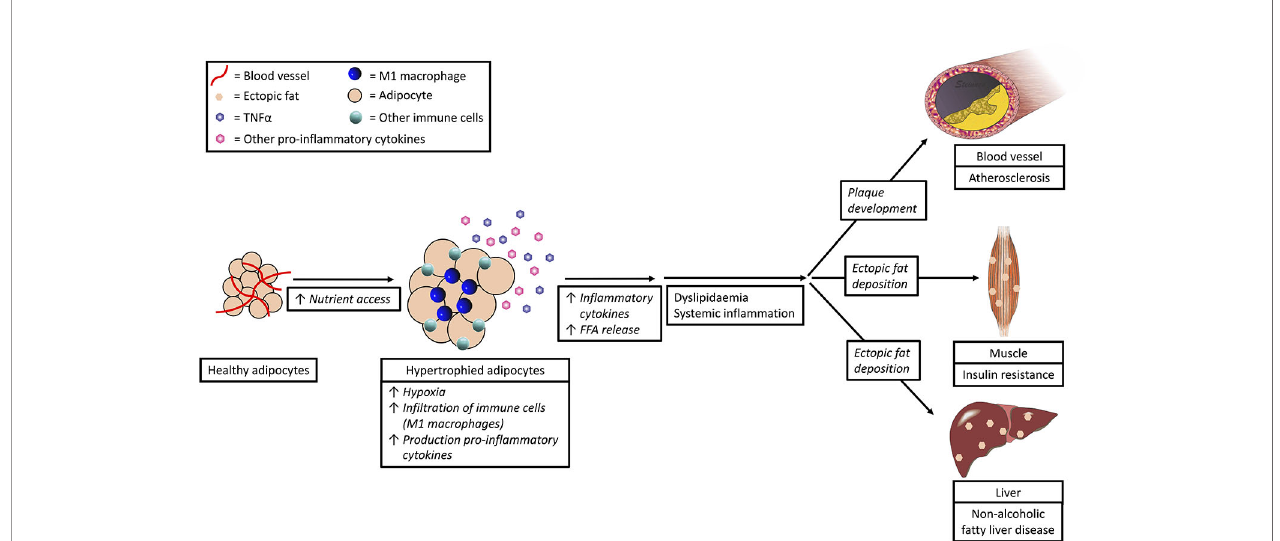
FIGURE 3 | Expansion of adipocytes due to nutrient access leads to dyslipidemia and in fl ammation and subsequent cardiovascular disease, insulin resistance, and non-alcoholic fatty liver disease.